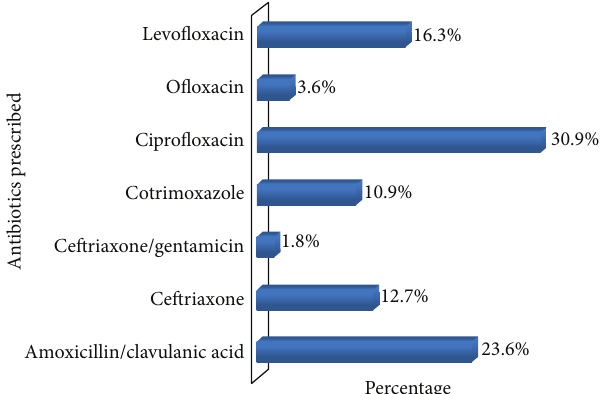
Figure 1: Relative amounts of antibiotics prescribed empirically for CAUTIs.